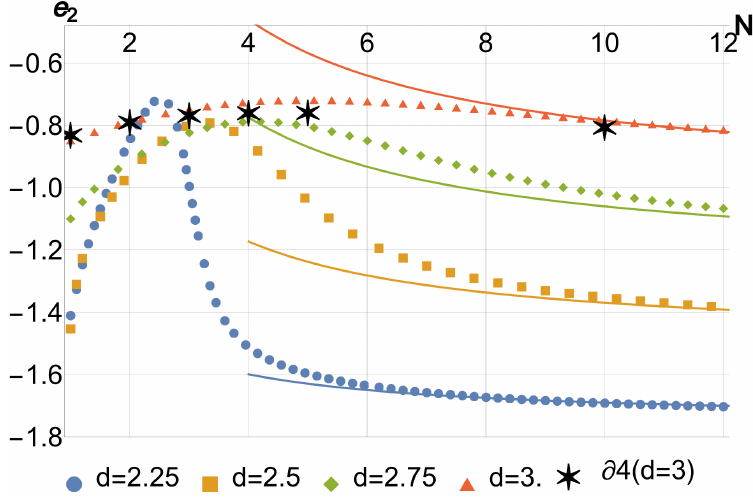
Figure 10: The subdominant eigenvalue e as function of N for a sequence of values 2 of d . Continuous lines denote the 1 / N -expansion predictions. The stars denote the results of derivative expansion at order ∂ 4 for d =